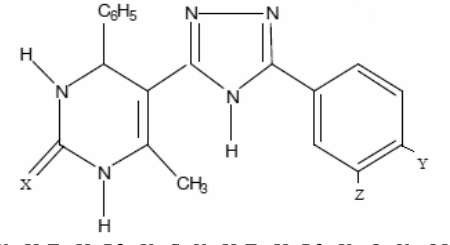
Figure 1. Structure of the